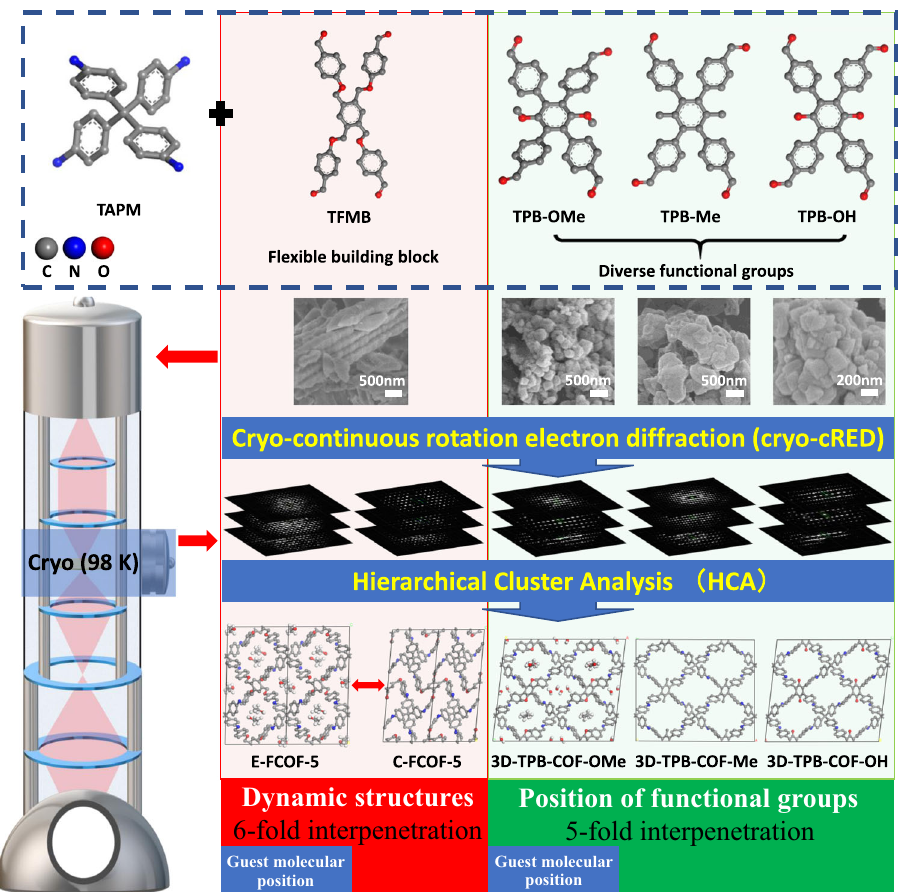
Fig. 1 Chemical information and work fl ow of enhanced cryo-cRED for the structure determination of polycrystalline 3D COFs. TAPM: tetra( p - aminophenyl)methane, TFMB: 1,2,4,5-tetrakis[(4-formylphenoxy)methyl] benzene, TPB-OMe, TPB-Me, and TPB-OH: methoxy-, methyl-, and hydroxy- functionalized 1,2,4,5-tetrakis(4-formylphenyl)benzene on the 3- and